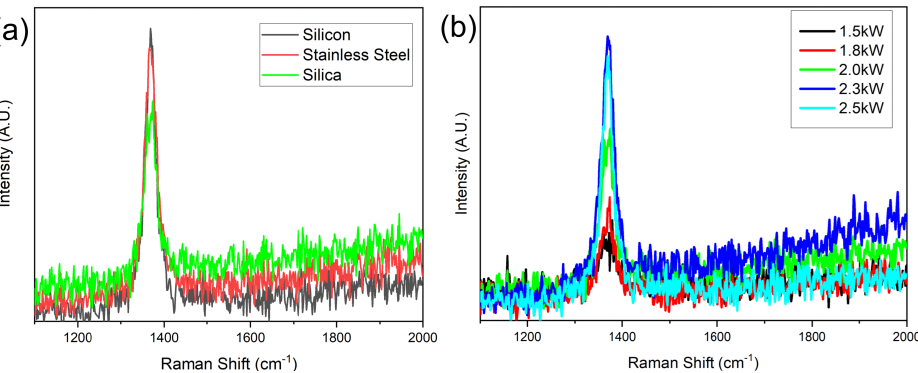
Figure 3. Raman spectra of ( a ) the samples in Figure 2 and ( b ) the samples with different ICP power at 380 °C substrate